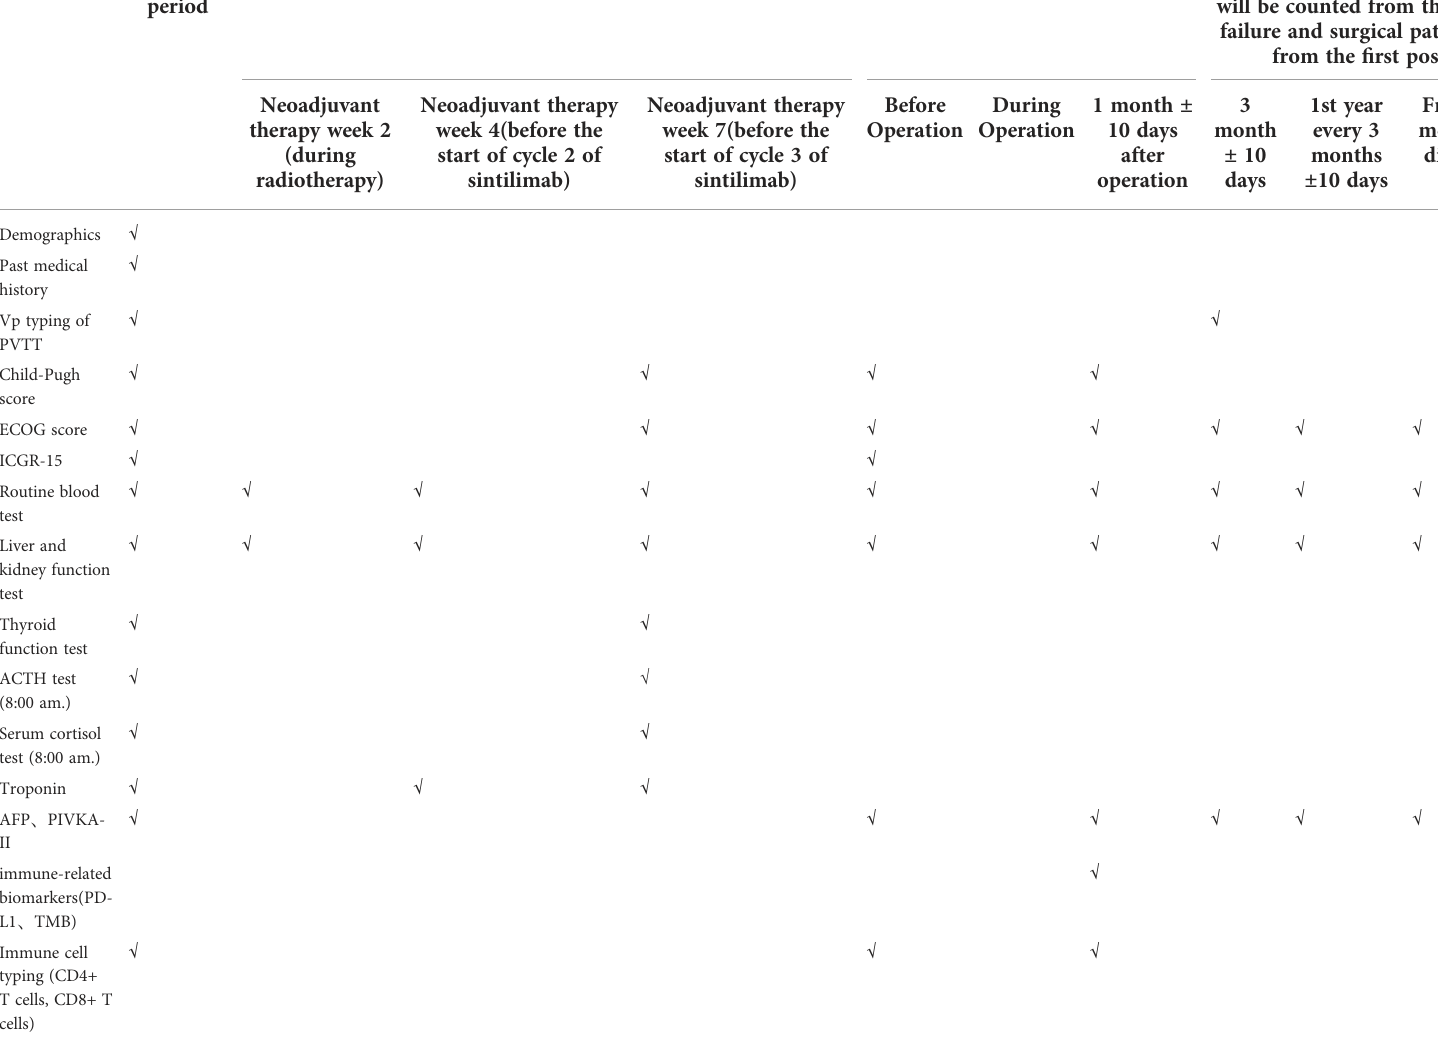
TABLE 4 Clinical visit information